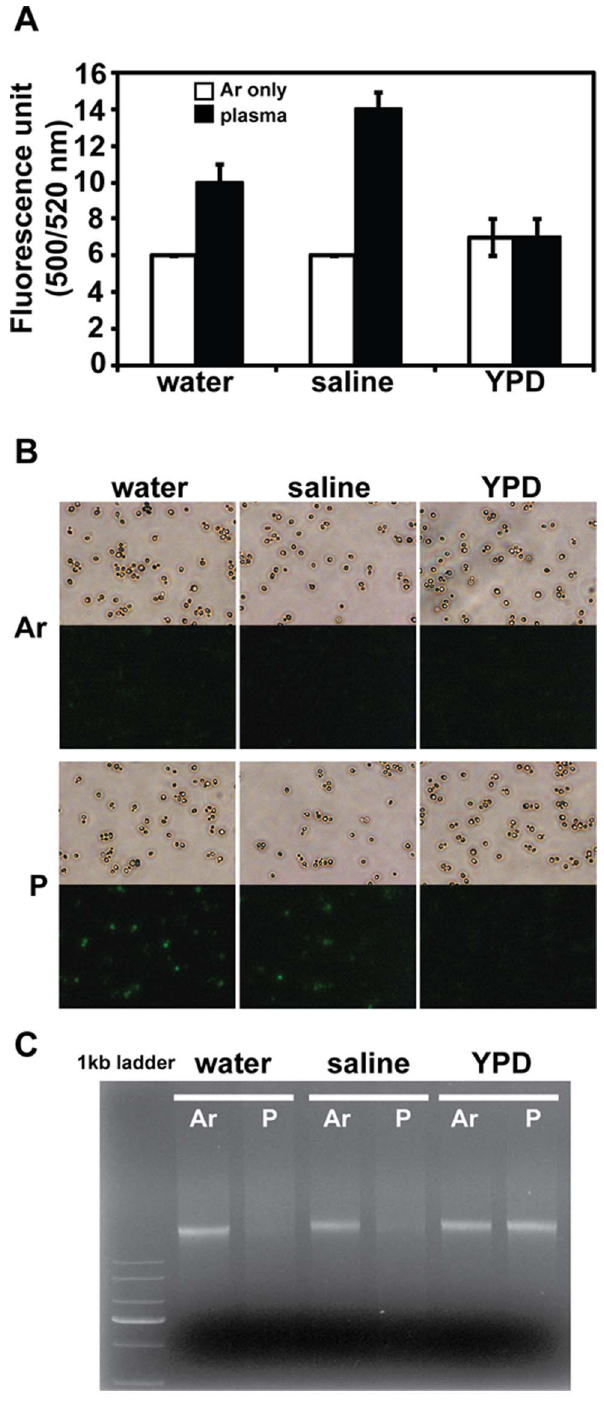
Figure 3. Lipid peroxidation and genomic DNA stability analyses. Yeast cells (2 6 10 7 ) were exposed to Ar gas and plasma for 3 min and used for the analyses of lipid peroxidation and genomic DNA. ( A ) Production of 4-hydroxynonenal (4-HNE) measured as fluorescence intensity at 500/520 nm in cells treated with plasma in water, saline, and YPD. Each value is the average of three technical replicates. ( B ) Fluorescence image of cells after Ar gas and plasma treatment in water, saline, and YPD. ( C ) Agarose gel electrophoresis of genomic DNA. Same amount of genomic DNA (2 m g) was loaded on the 1% agarose gel.